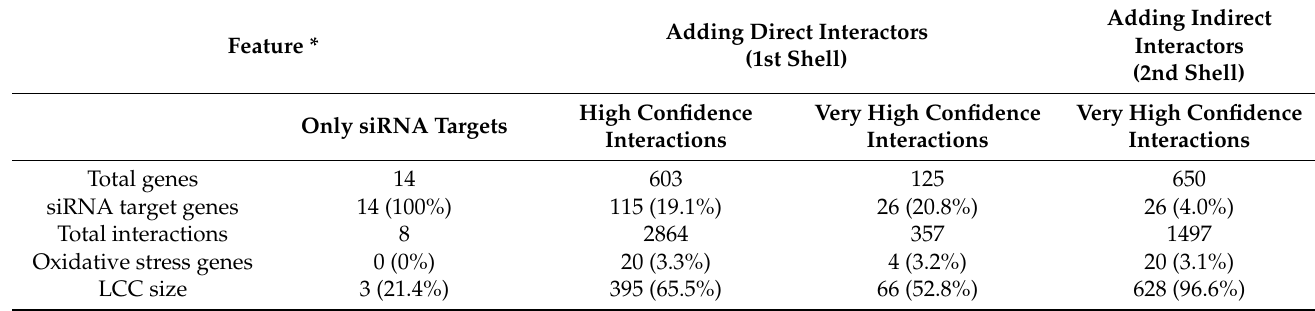
Table 1. Main features of obtained protein-protein interaction (PPI) networks.